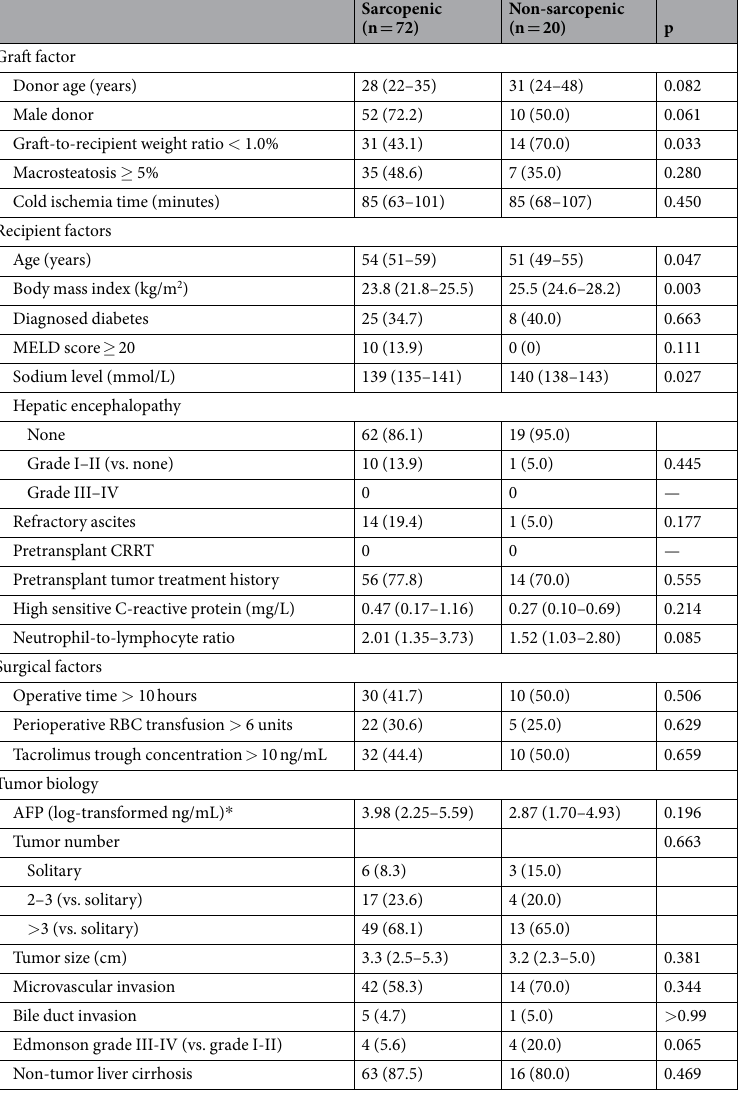
Table 1. Characteristics of patients included in the study. Data are presented as median (25th percentile, 75th percentile) or frequency (percent). AFP, alpha-fetoprotein; MELD, model for end-stage liver disease; RBC, red blood cell. CRRT, continuous renal replacement therapy. * P values were calculated for log-transformed values due to the skewed